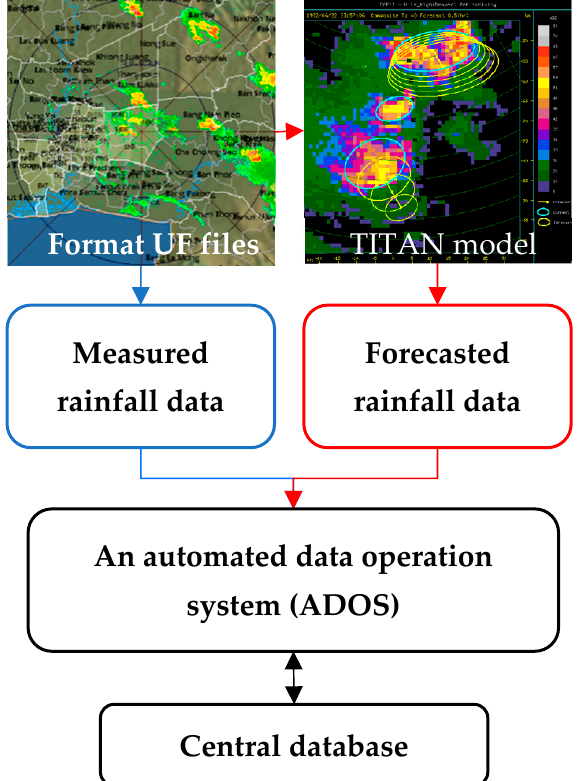
Figure 4. The framework for rainfall input data processing.